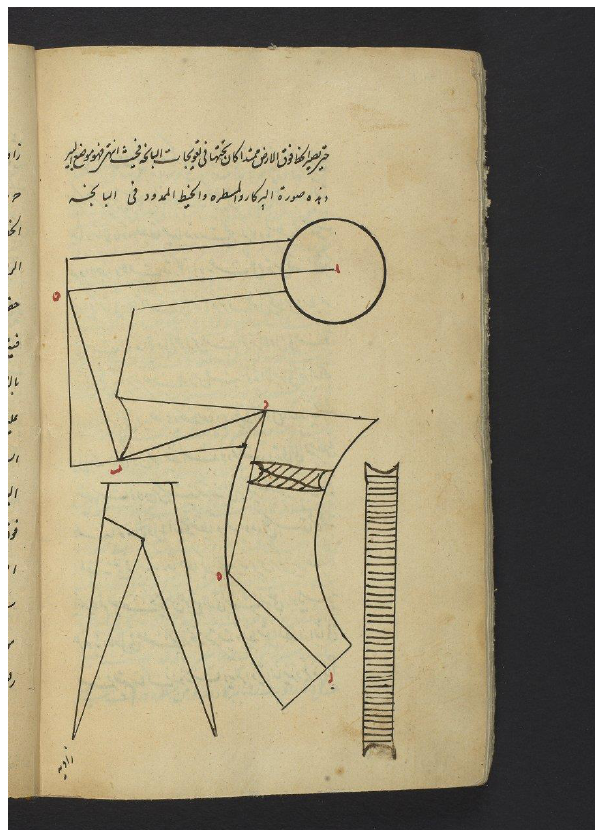
Figure 9. Illustrations of calliper, ruler, and planning and procedure to dig in a tortuous qanat and record deviations. Diagram f45v from Karaji (1675). Permanent link: http://hdl.library.upenn.edu/1017/d/ medren/9948256513503681 (last access: 29 July